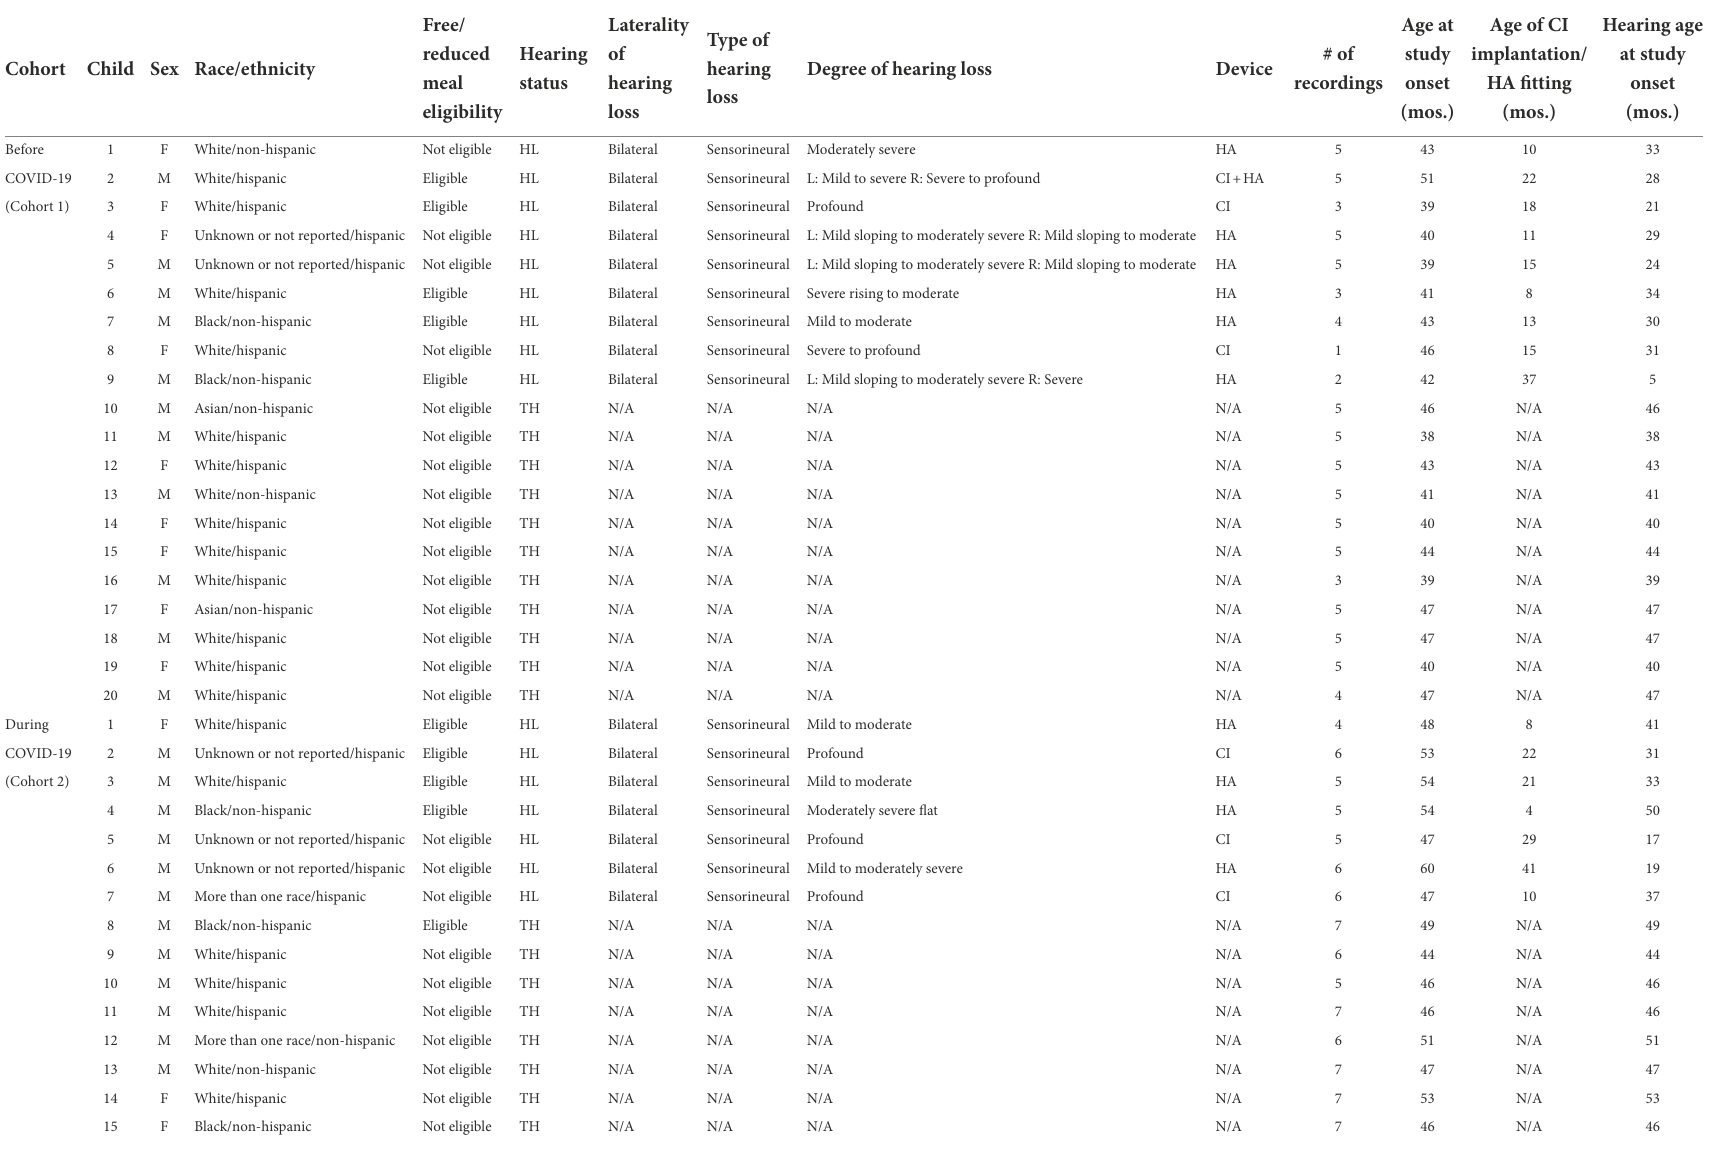
TABLE 1 Participant characteristics for children by